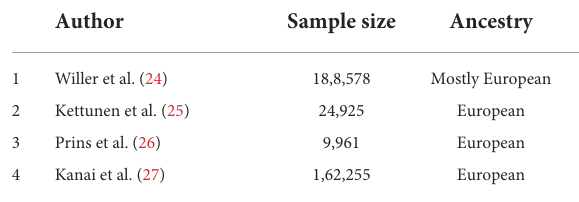
TABLE 1 Summary information of GWAS for blood lipid profiles.